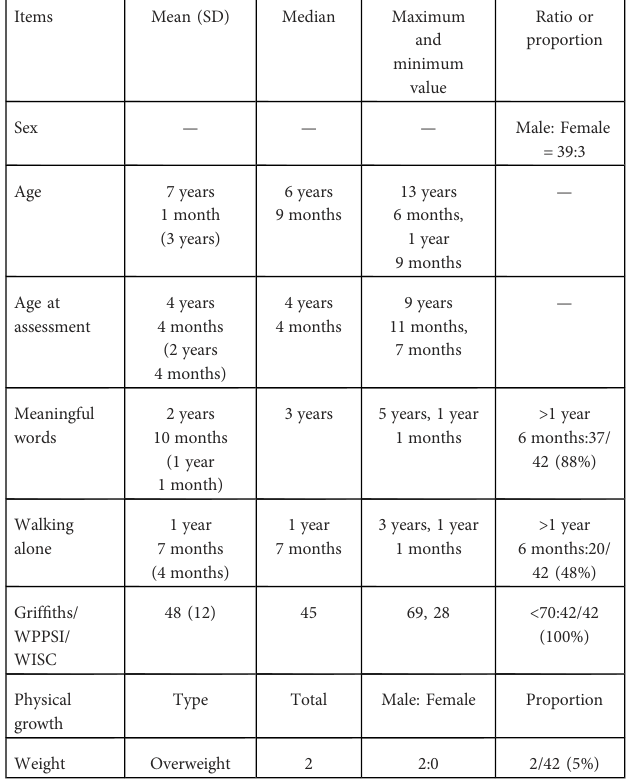
TABLE 3 Proportion of FXS children with certain features in the total number of patients. Repetitive behaviors